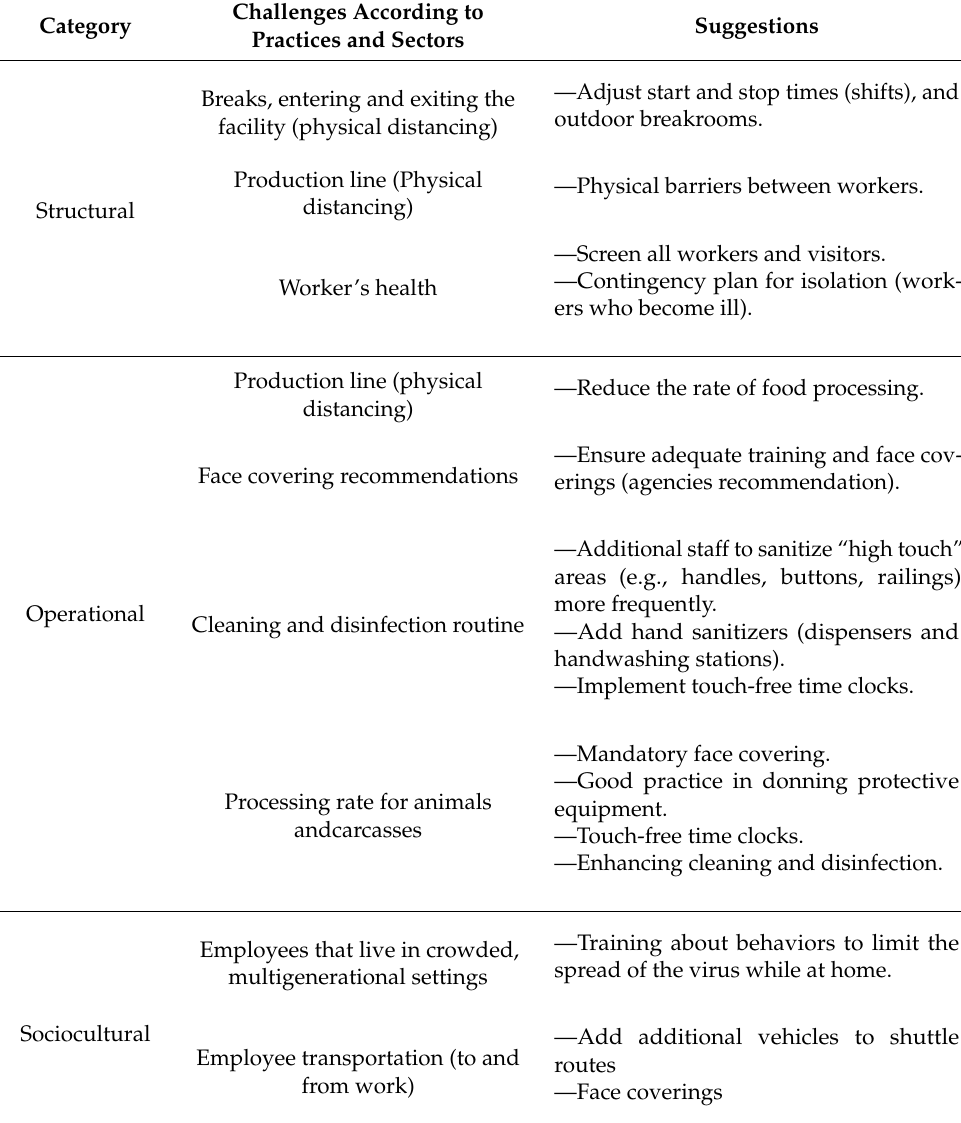
Table 4. Recommended changes to prevent and control SARS-CoV-2 in facilities according to the following categories: structural, operational, and